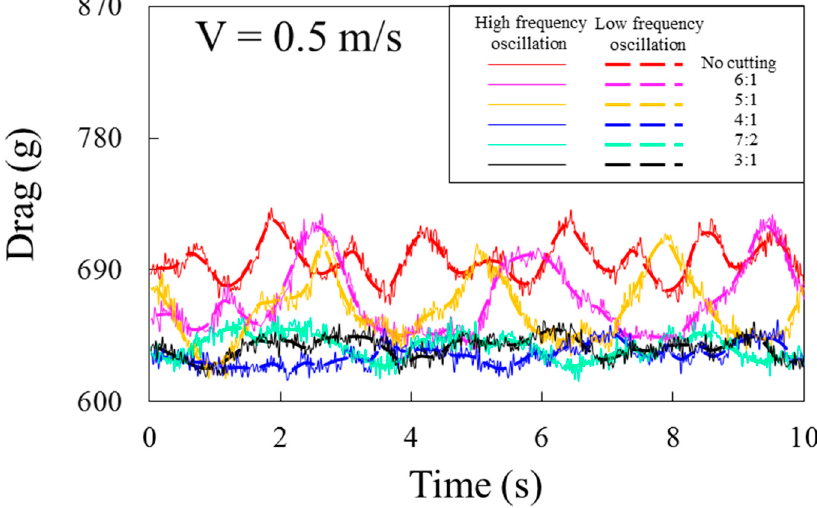
Figure 10. Variations of drag for codends with catch in different cutting ratios.